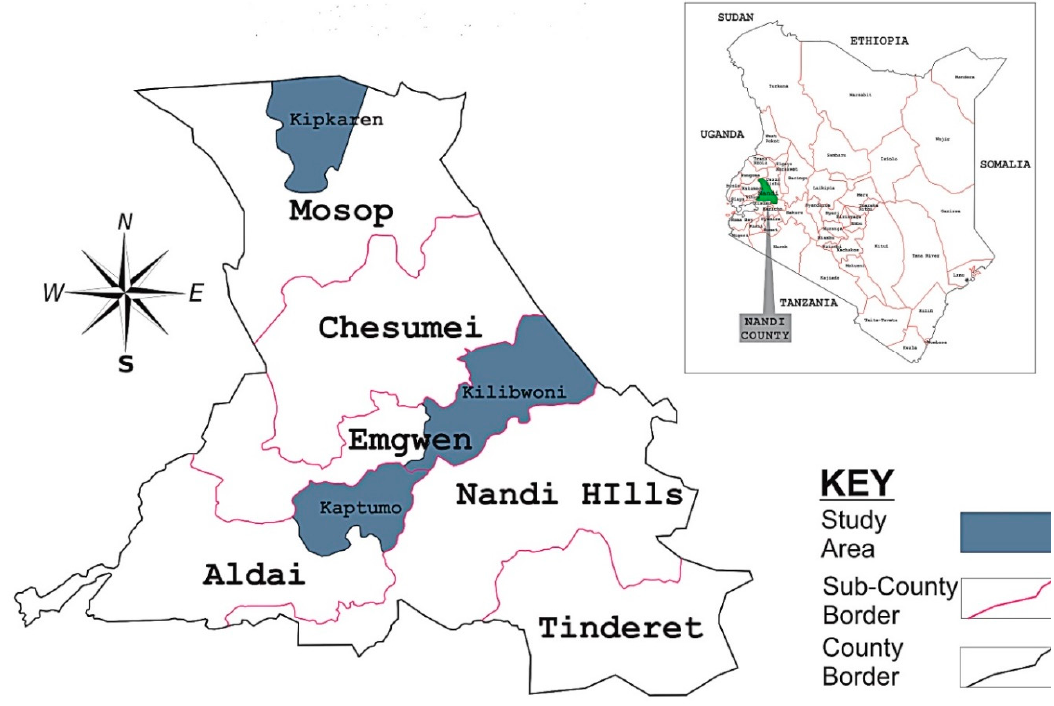
Figure 1. Map of Nandi County showing the study areas .